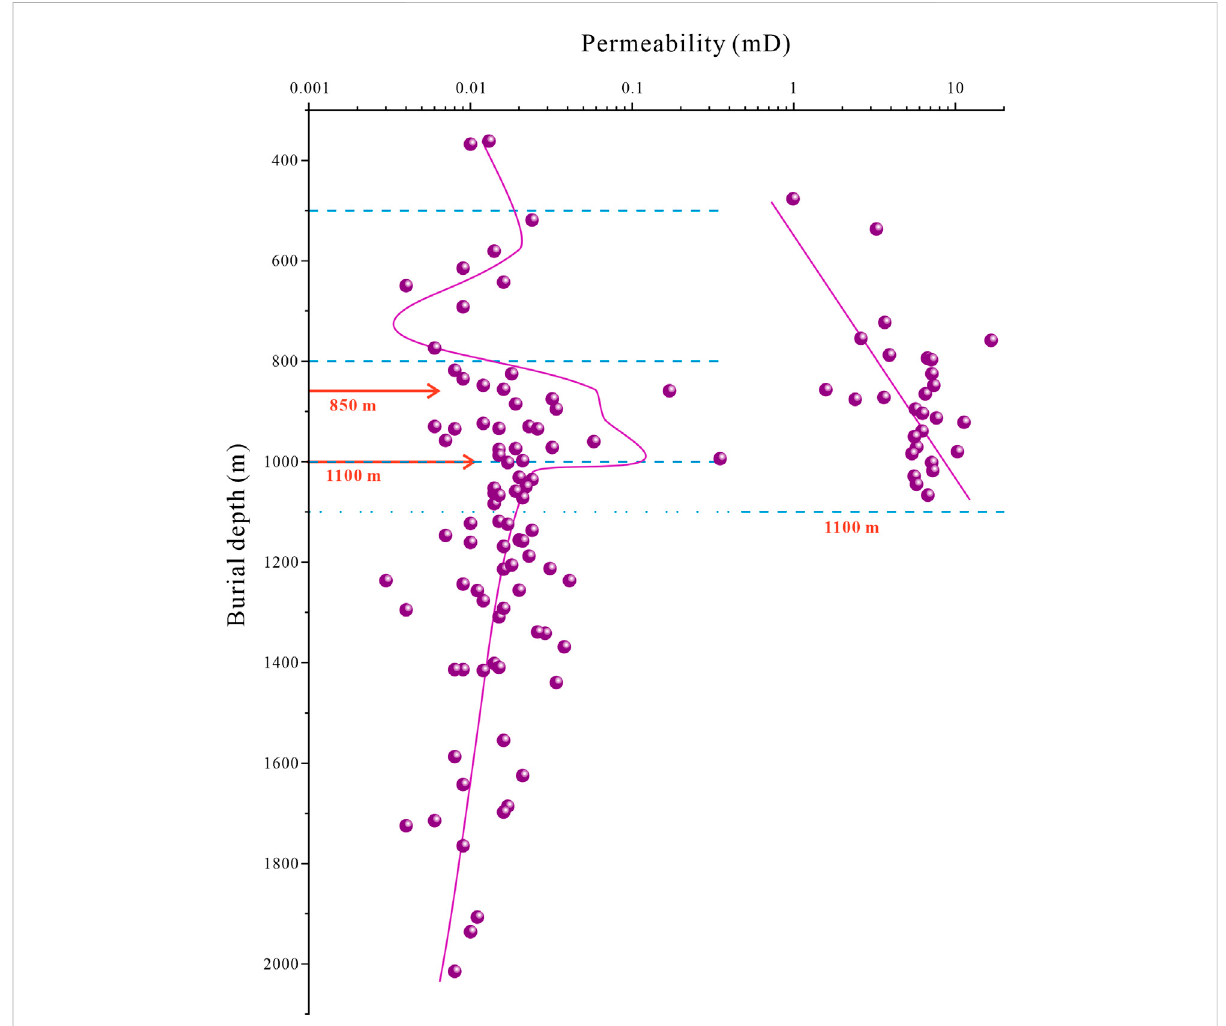
FIGURE 6 Vertical variation of permeability with burial